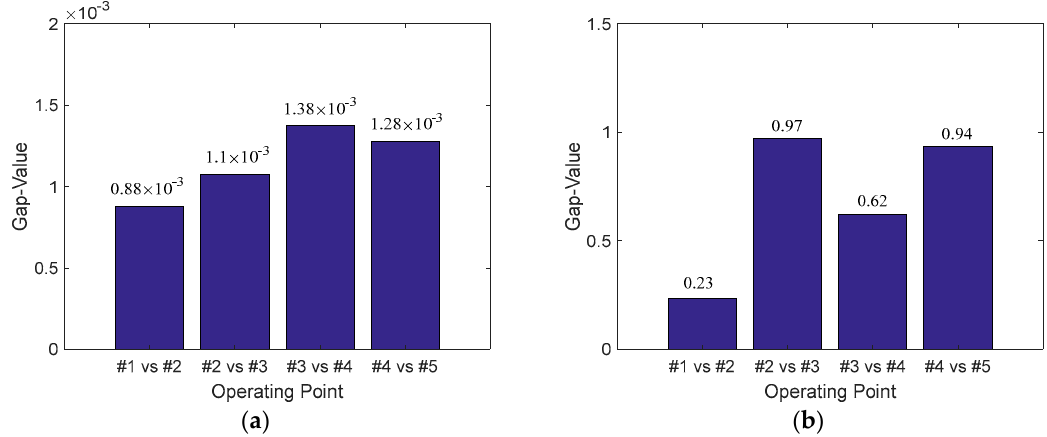
Figure 3. The value of V-gap between different operating points in MGT-CCP system. ( a ) Nonlinearity distribution of MGT-CCP process under varying fuel u 1 ; ( b ) Nonlinearity distribution of MGT-CCP process under varying refrigerant valve opening u 2 .